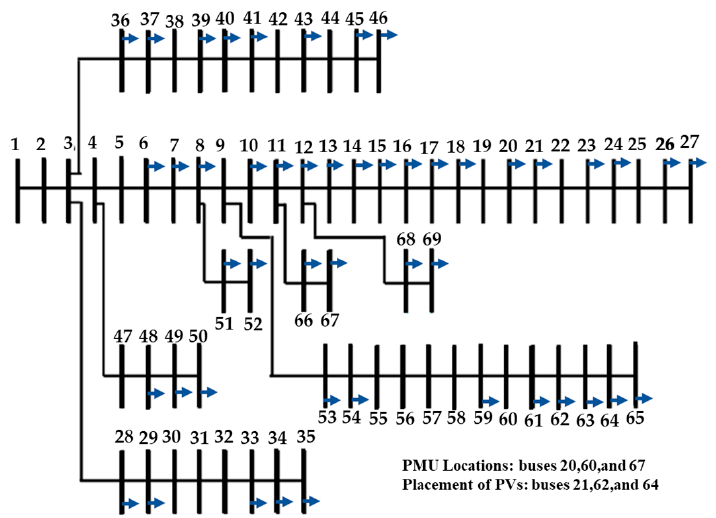
Figure 10. The modified IEEE Standard 69 Bus Distribution